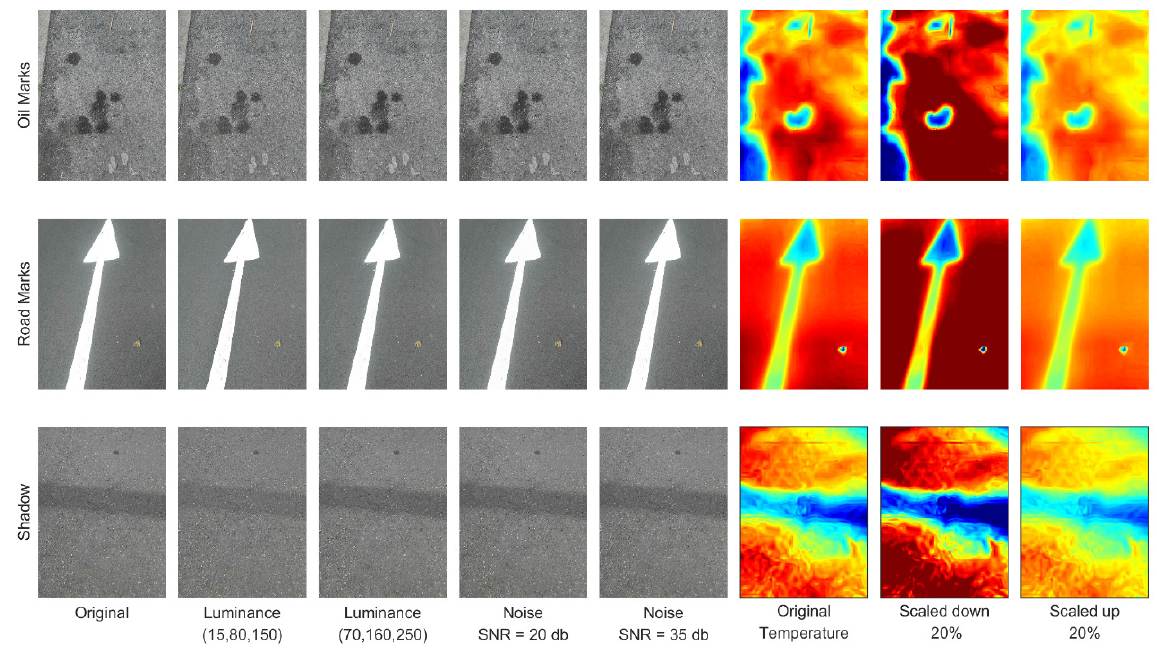
Figure 5. Data augmentation of oil marking, road marking and shadow.